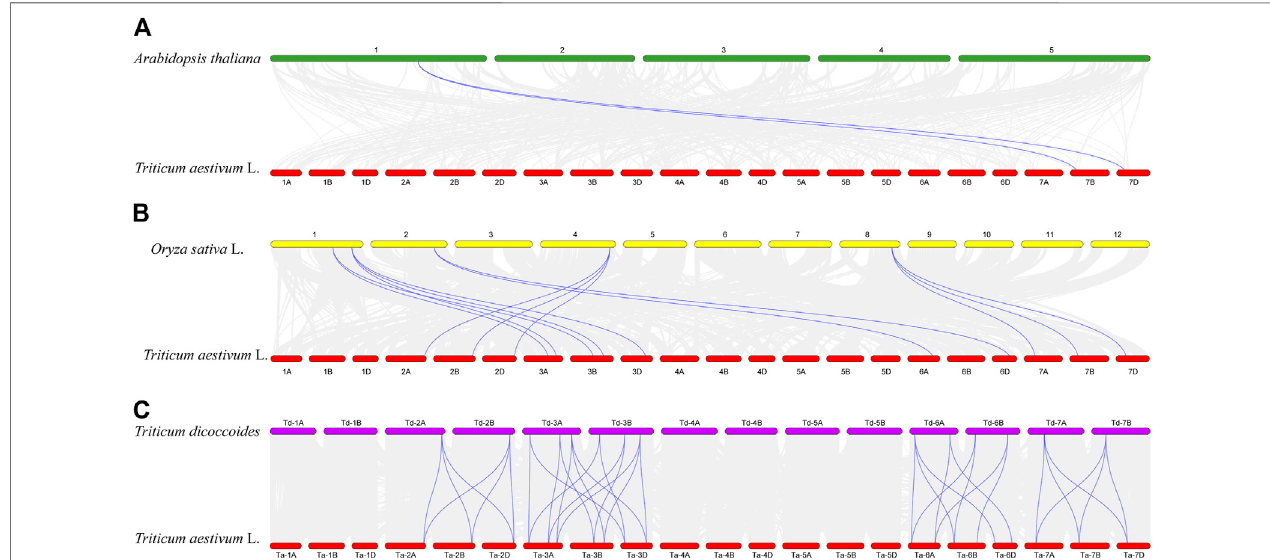
FIGURE4| Collinearity analysisof TaCLC genesbetween Triticumaestivum L. and Arabidopsis thaliana (A) , Oryzasativa L. (B) ,and Triticumdicoccoides (C) . The chromosomesofwheat,Arabidopsis,rice,andemmerareexpressedinred,green,yellowandpurple,respectively.Thegraylinerepresentsallthecollinearitygenepairs betweenthetwospecies,andthebluebrightlinerepresentsthecollinearitygenepairbetweenthe TaCLC genesofwheatandthecorrespondingspecies.Thenamesof each chromosome are shown above and below.